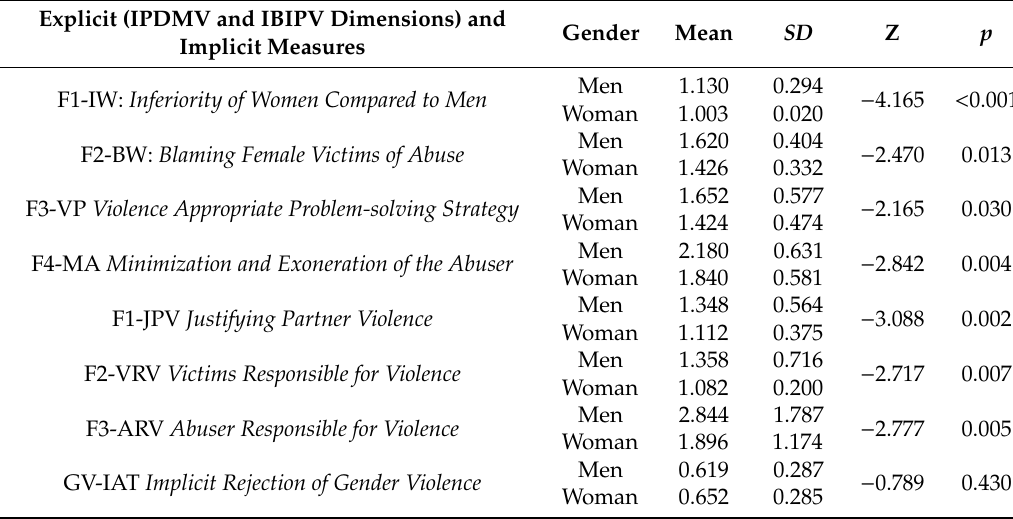
Table 8. Mean di ff erences in explicit and implicit measures by gender ( ≤ 29 years). Explicit (IPDMV and IBIPV Dimensions) and Gender Mean Implicit Measures F1-IW: Inferiority of Women Compared to Men